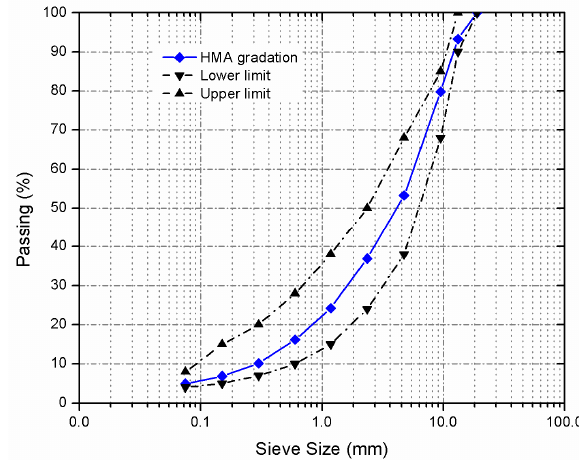
Figure 1. Chart of aggregate gradation.